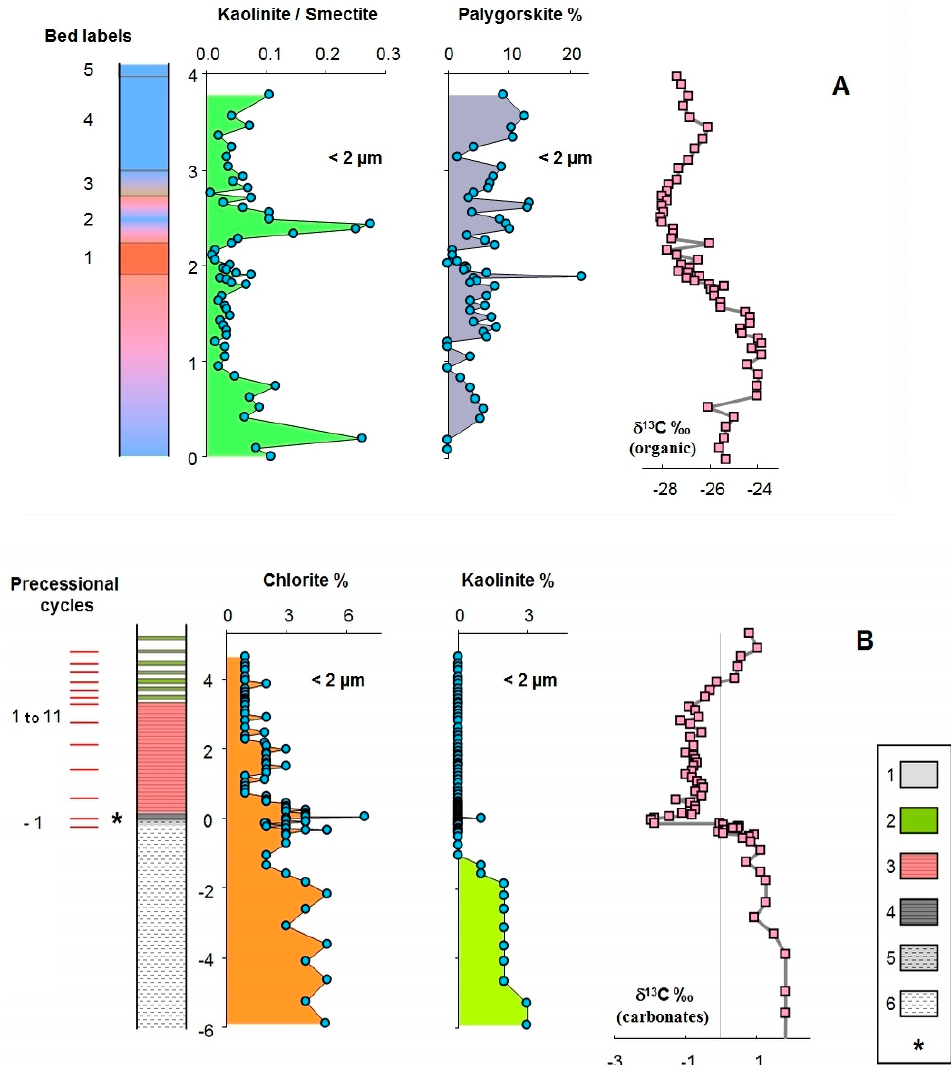
Figure 3. Examples of high-resolution sampling for clay mineral analyses at the PETM; ( A ) Dababiya NW (Egypt): the palygorskite variability through the section is detectable, with short intervals of absence; a short-lived episode of an enhanced kaolinite–smectite ratio is detectable during the maximum lightning of the carbon isotope composition; the chromatic effects column suggests further subdivisions within some of the bed (redrawn after [50], see also Table S1 for a schematic summary of bed labeling); ( B ) Forada section (Italy): the δ 13 C carbonates oscillations at cycle − 1, 1, and 2 are accompanied by opposite chlorite variations despite the very low content of the mineral; the very base of cycle 1 (black shale) is detectable by a sharp pulse of chlorite and kaolinite (single sample); simplified lithology: 1 = limestone; 2 = marl; 3 = clay–marl; 4 = laminated clay to marly clay; 5 = marl (partially decarbonated); 6 = marl; * = 1 mm thick black shale (base of cycle 1); redrawn from [24].